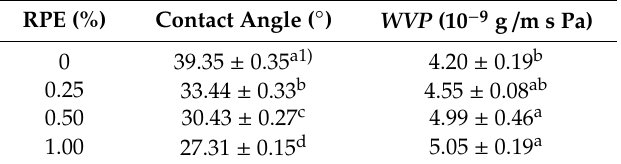
Table 3. Water barrier properties of the CJP films containing di ff erent concentrations of